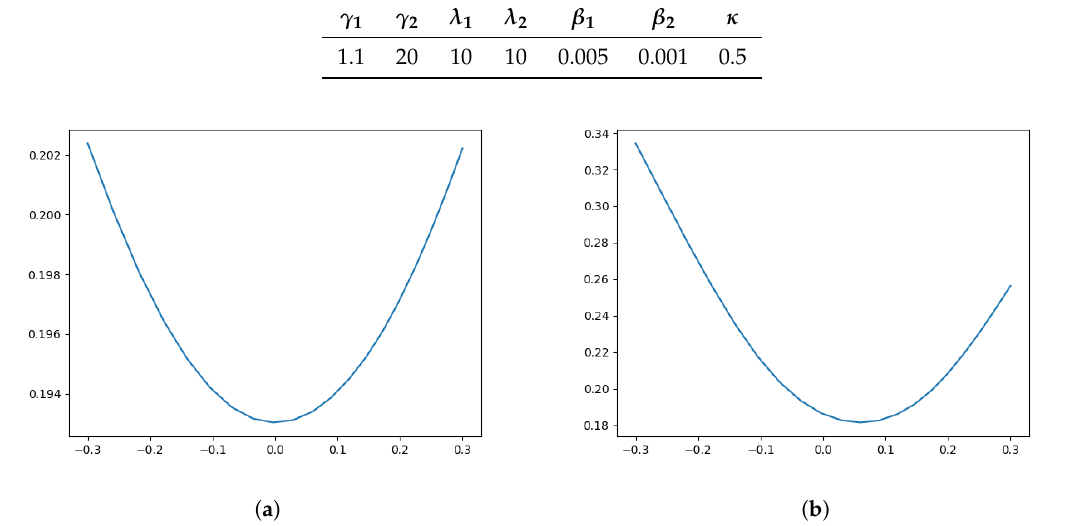
Table 1. Fixed Parameters for the ground truth assumption a 2